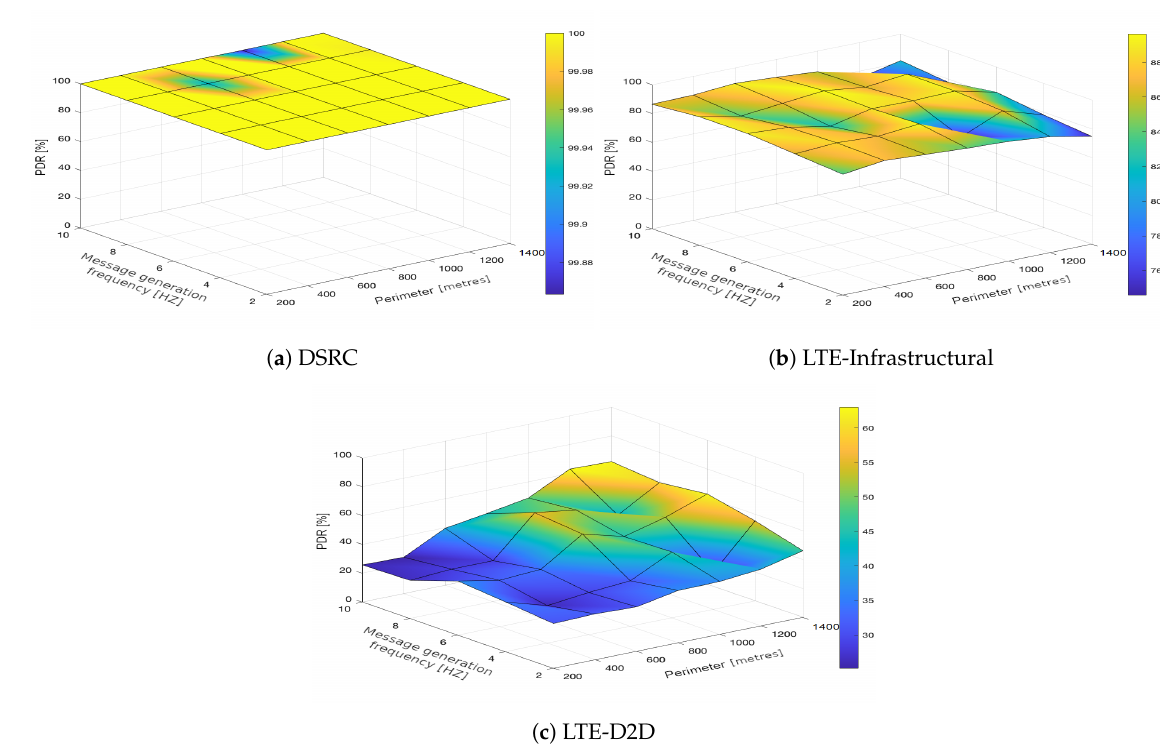
Figure 2. Packet delivery ratio obtained for the traffic intensity of 250 vehicles per hour.